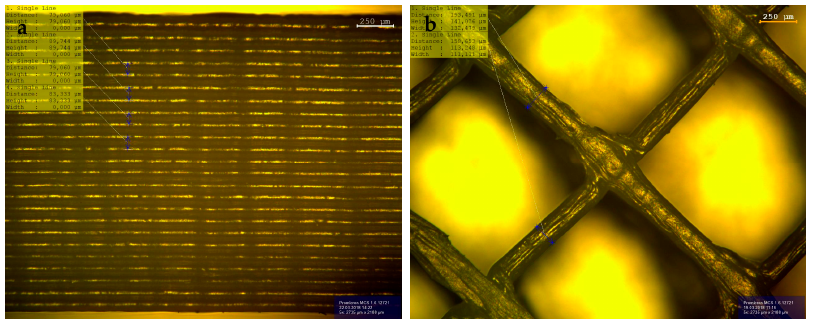
Figure 8. ( a ) Side view and ( b ) top view of the open test structure.